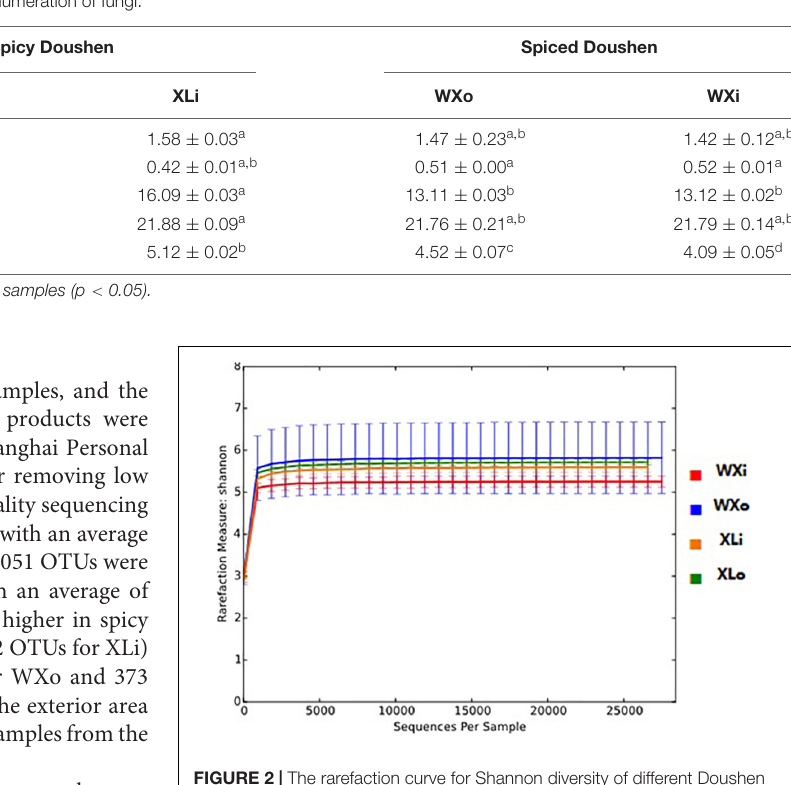
FIGURE 2 | The rarefaction curve for Shannon diversity of different Doushen